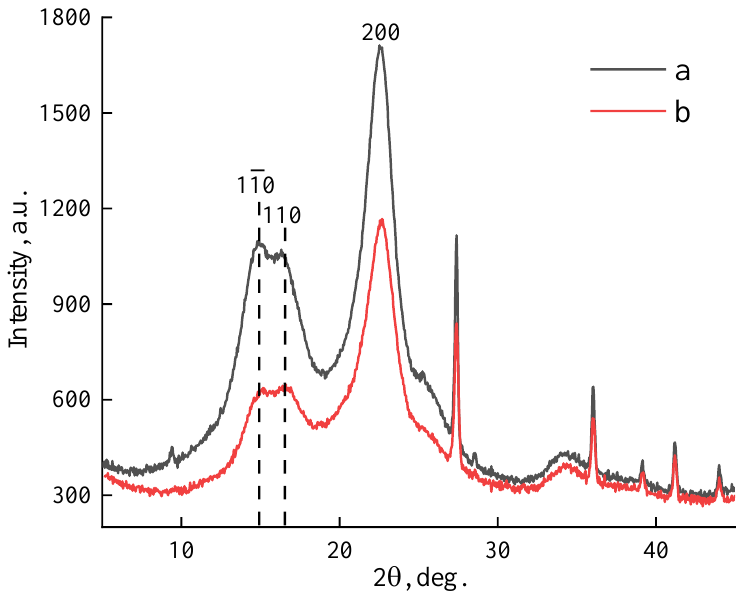
Figure 3. Diffractograms of paper samples before ( a ) and after ( b ) solvent treatment. The native cellulose (polymorph I) from which the paper was obtained was character- ized by peaks in the 2 θ ~14.8 ◦ , ~16.6 ◦ , and ~22.6 ◦ regions, which corresponded to planes with Miller indices 1–10, 110, and 200 [49]. The interaction of cellulose with the solvent,